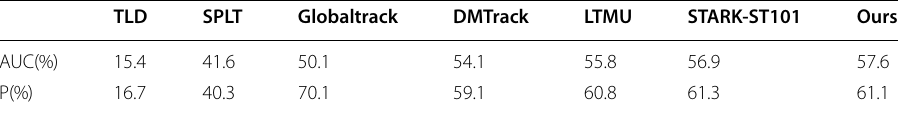
Table 2 AUC and P on the TLD dataset TLD